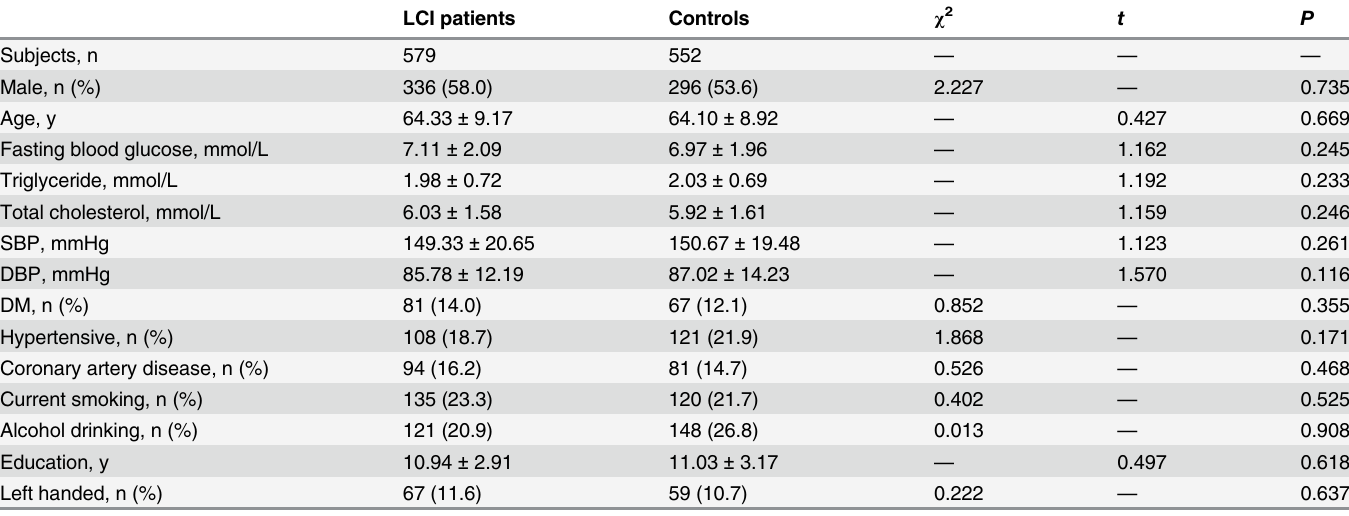
Table 1. Baseline characteristics of CLI patients and controls. *